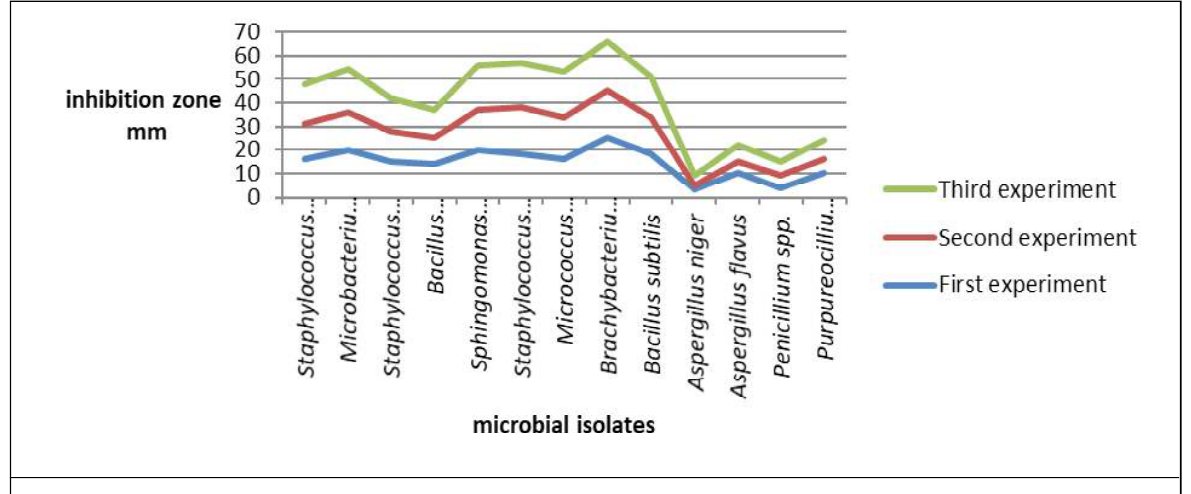
Figure 4: The effect of 10% of C. myrrh extract against microbial isolates 3.4. Compared the efficiency of Commiphora myrrh with a chemical reagent used in a salon